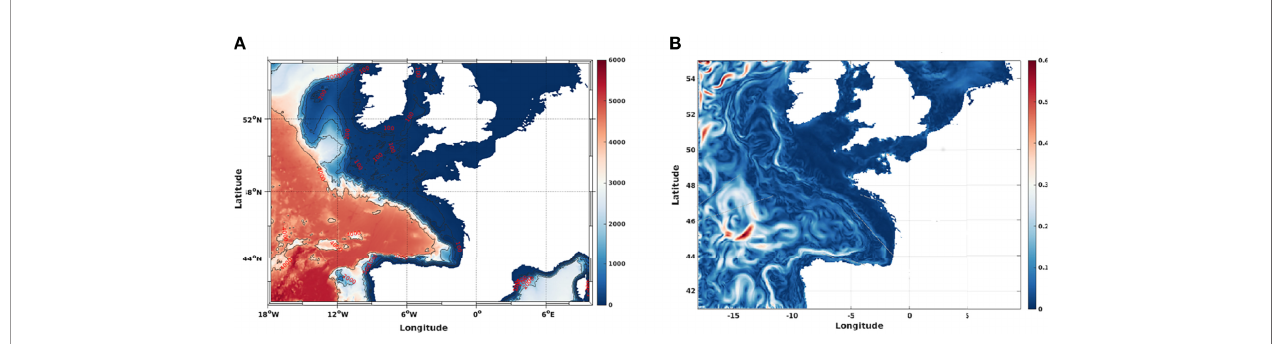
FIGURE 2 | (A) Bathymetry of the modelled region, (B) Sample daily averaged surface current in the Bay of Biscay in the particle tracking